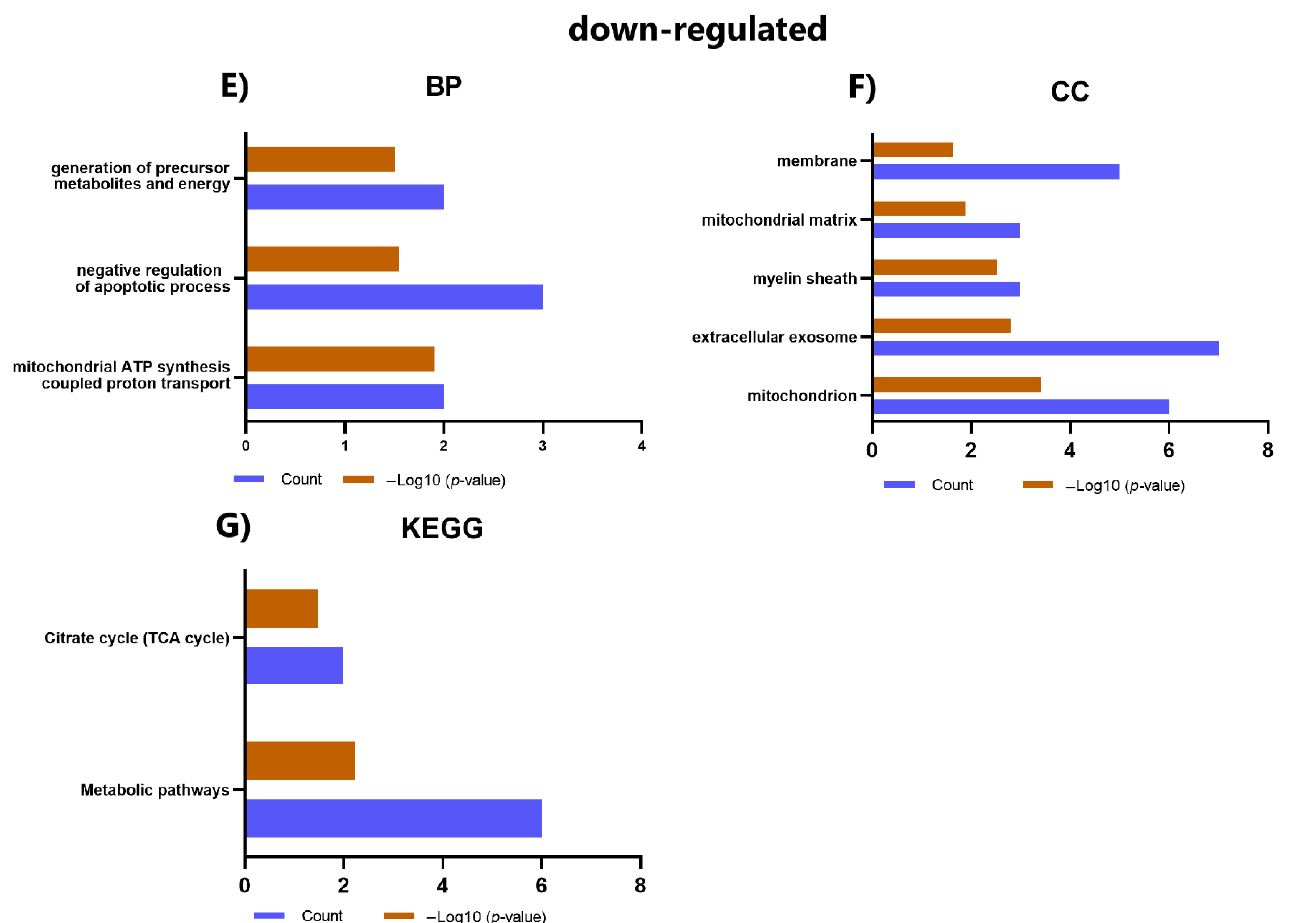
Figure 5. GO and KEGG analysis of DEPs ( A ) The significant terms enriched for BP in up-regulated proteins. ( B ) The significant terms enriched for MF in the up-regulated proteins. ( C ) The main terms enriched for CC in up-regulated proteins. ( D ) Top enriched terms for KEGG pathways in up-regulated proteins. ( E ) The significantly enriched terms for BP in the down-regulated proteins. ( F ) Top enriched terms for CC in down-regulated proteins. ( G ) Top enriched terms for KEGG pathways in down-regulated proteins. If there were more than five enriched terms for one of the categories, the five most representative ones were selected according to the p -value.